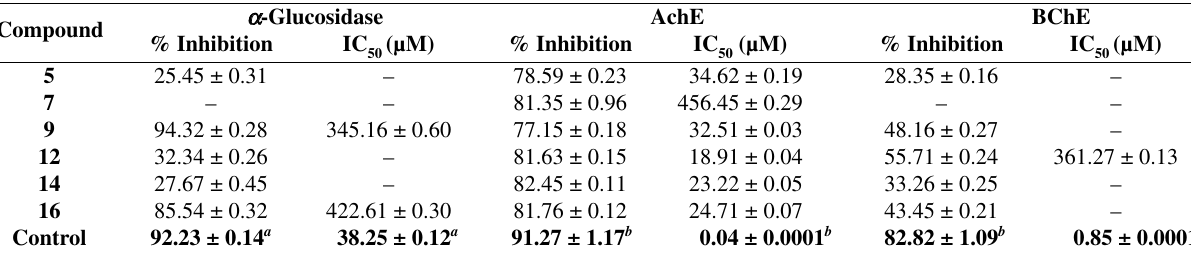
Table 1 . Bioactivity studies of different carbamate derivatives bearing 2-furoyl-1-piperazine αα -Glucosidase